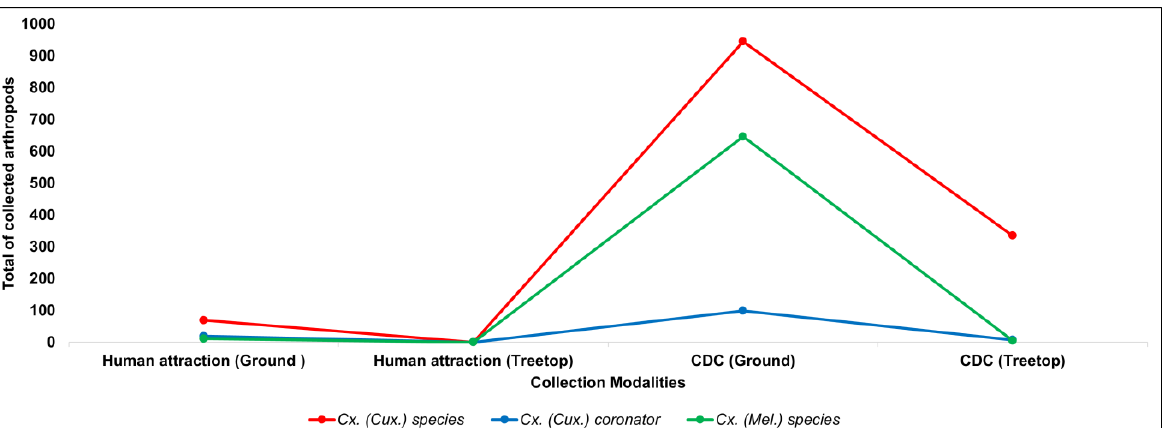
Figure 3. Cytopathic effect (ECP) displayed by C6/36 and Vero cell lines inoculated with sample BeAr848894. ( a ) ECP in C6/36 cells showing formation of syncytium highlighted by red arrows. ( b ) ECP in Vero cells, with modification in the cell morphology and destruction of the monolayer. ( c )